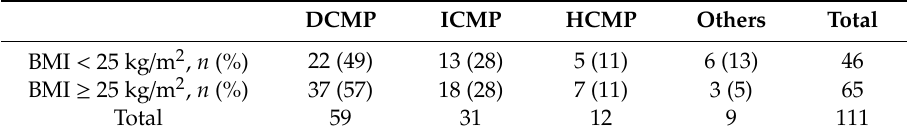
Table A1. Diagnosis of included